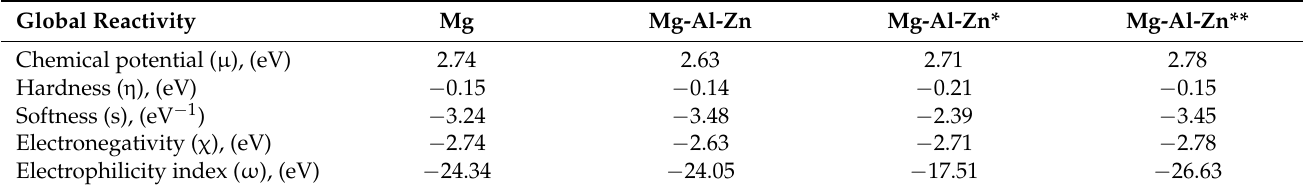
Table 2. Global reactivity properties of Mg and